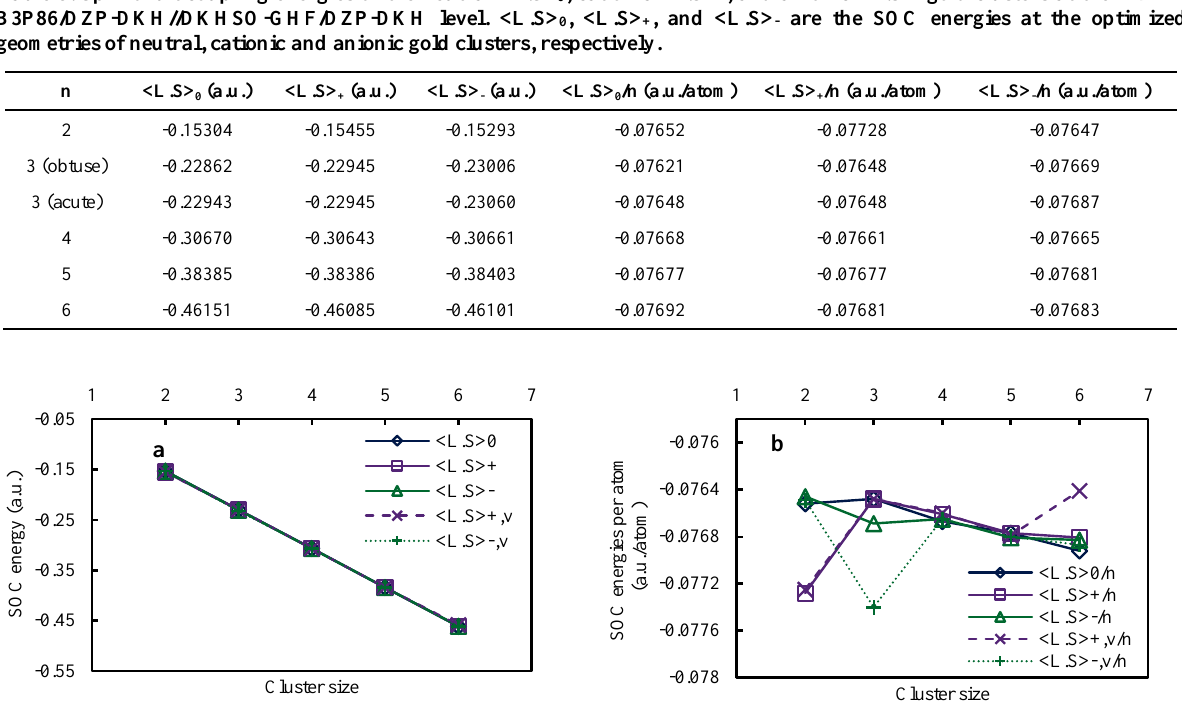
Figure 7. Variation of (a) Maximal Spin-orbit coupling energies of the neutral (<L.S> 0 ), cationic (<L.S> + ) and anionic (<L.S> - ) gold clusters, (b) Spin-orbit coupling energies per atom of the neutral (<L.S> 0 /n), cationic (<L.S> + /n) and anionic (<L.S> - /n) gold clusters, at the DKH2-B3P86/DZP-DKH//DKHSO-GHF/DZP-DKH level of theory. Subscript ‘v’ indicates